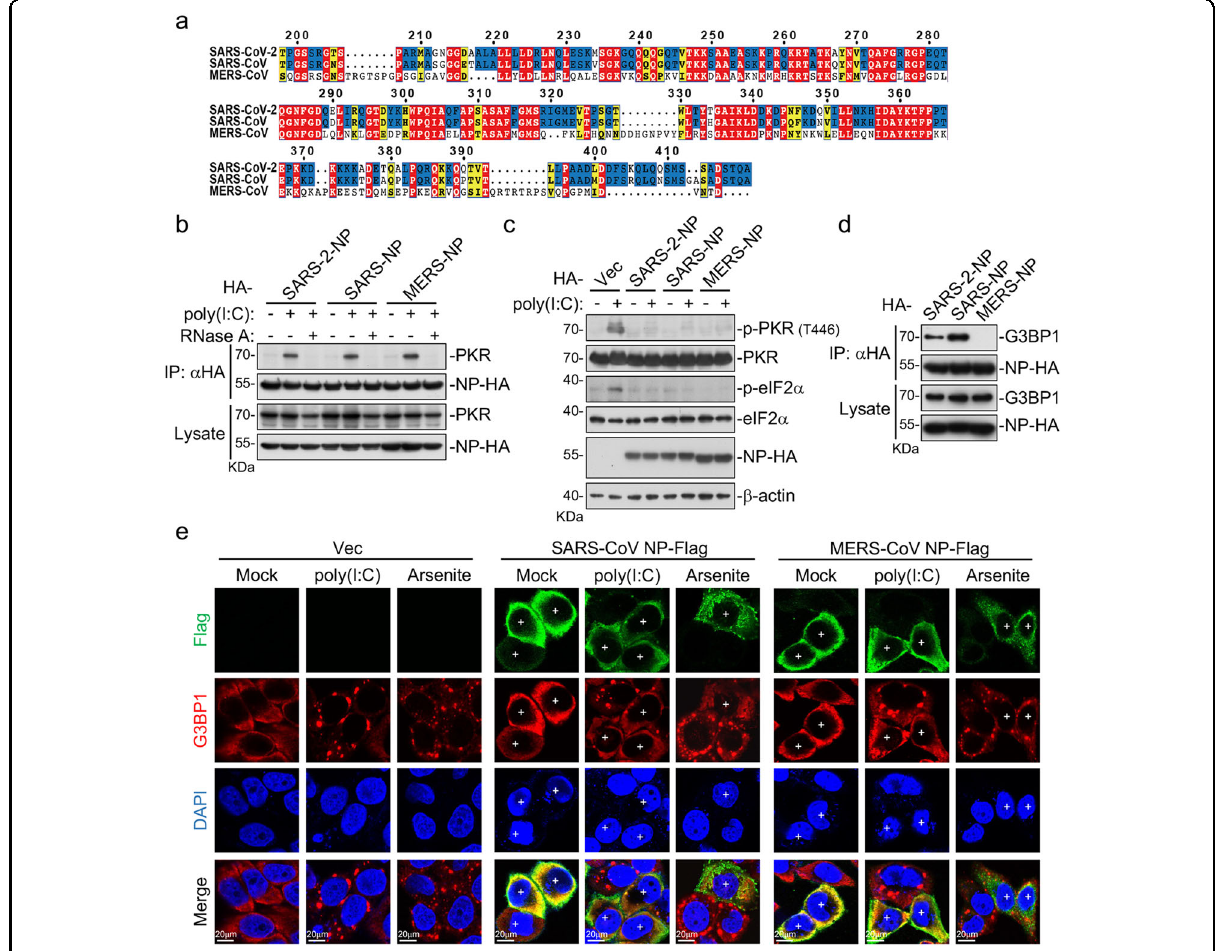
Fig. 5 Inhibition of SG formation by NPs of three coronaviruses. a The amino acid sequences of NPs of SARS-CoV, SARS-CoV-2, and MERS-CoV were aligned by MAFFT (version 7.4.71) and visualized in ESPrit (version 3.0) 52 . The conserved amino acids are highlighted. Residues highlighted in red are fully conserved and those in yellow are not conserved. Residues highlighted in blue are conserved between SARS-CoV-2 and SARS-CoV, but not MERS-CoV. b The NPs of SARS-CoV-2, SARS-CoV, and MERS-CoV associate with endogenous PKR. HEK293T cells (5 × 10 6 ) were transfected with the indicated plasmids for 24 h. The lysates were left untreated or added with poly(I:C) (8 μ g) or treated by RNase A. Co-immunoprecipitation and immunoblot analysis were performed with the indicated antibodies. c The NPs of SARS-CoV-2, SARS-CoV, and MERS-CoV inhibit poly(I:C)-induced phosphorylation of PKR and eIF2 α . HEK293T cells were transfected with the indicated plasmids for 12 h and then further transfected with poly(I:C) (2 μ g) for 10 h before immunoblotting analysis with the indicated antibodies. d The NPs of SARS-CoV-2 and SARS-CoV, but not MERS-CoV associate with endogenous G3BP1. HEK293T cells (5 × 10 6 ) were transfected with the indicated plasmids for 24 h. Co-immunoprecipitation and immunoblot analysis were performed with the indicated antibodies. e Effects of SARS-CoV and MERS-CoV NPs on poly(I:C)- and sodium arsenite-induced SG formation. HeLa cells were transfected with Flag-tagged SARS-CoV or MERS-CoV NP expression plasmid for 12 h, and then further transfected with poly(I:C) (2 μ g) for 10 h or treated with sodium arsenite (1 mM) for 1 h. Cells were immunostained for Flag (green) and G3BP1 (red). Nuclei were stained with DAPI (blue). The cells were observed with a Nikon confocal microscope under a 60× oil objective. “ + ” indicates the cells expressing